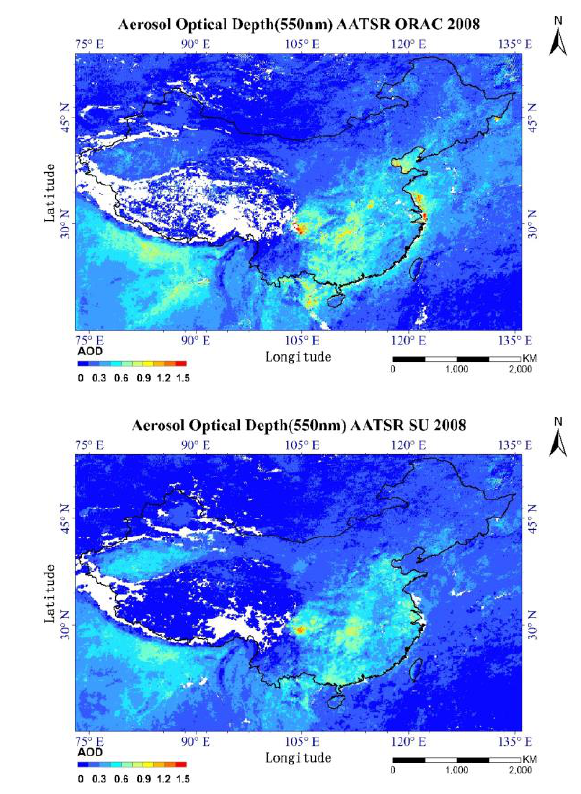
Figure 2. Annual averaged three AATSR AOD (550 nm) (ADV v3.11, ORAC v4.10, and SU v4.32) distributions over China in